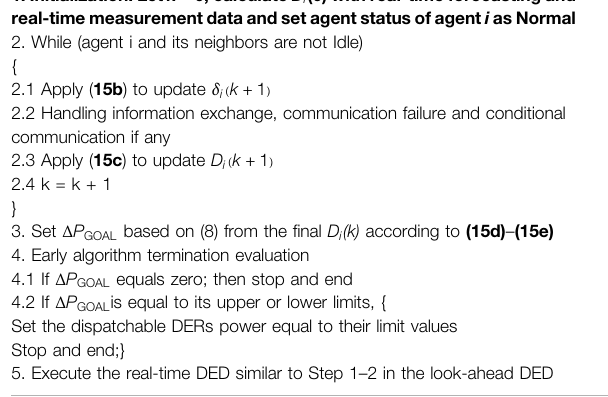
TABLE 1 | Pseudo-code of the look-ahead DED for each agent. Preparation: Calculate the power transfer distribution factor matrix D